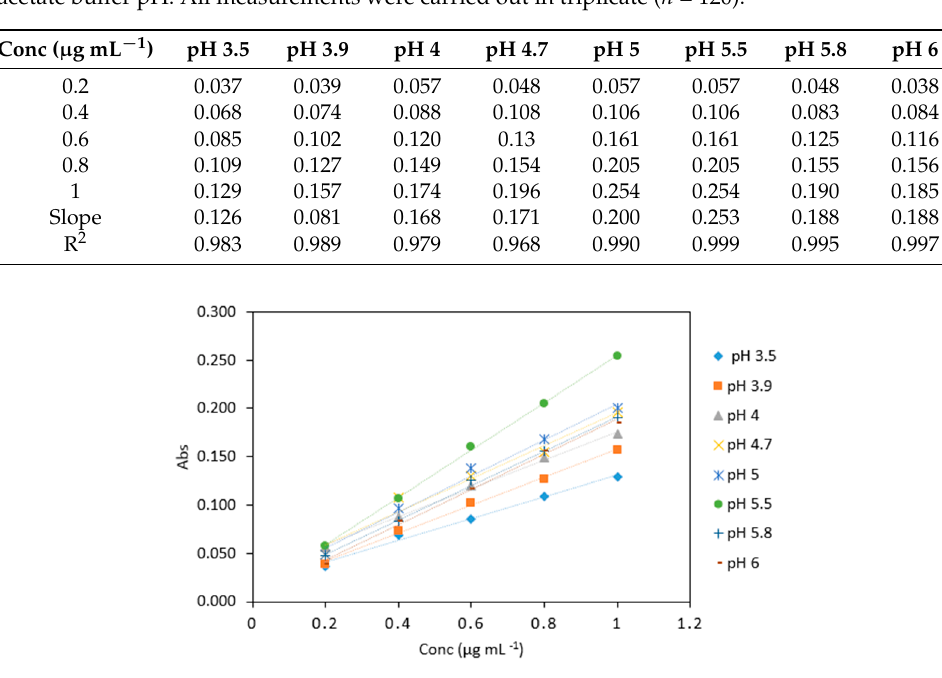
Table 4. Average absorbance of arsenic samples (0.2–1 μ g mL − 1 ) analyzed with various sodium triacetate buffer pH. All measurements were carried out in triplicate ( n = 120).